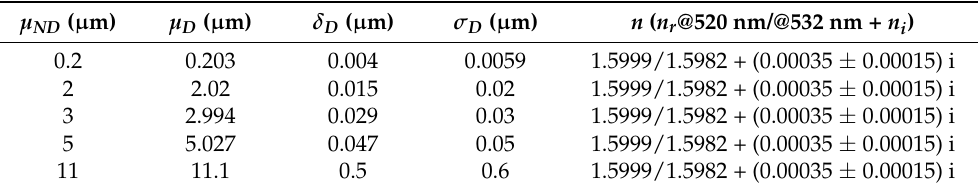
Table 1. The specification of polystyrene beads used in this study. Beads of a nominal diameter µ ND are assumed to be normally distributed with an actual mean diameter of µ D and a standard deviation of σ D . σ D represents the uncertainty in determining µ D at 95% confidence level. The complex refractive index ( n ) at 532 nm and 520 nm are also